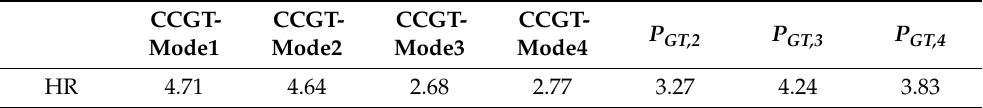
Table 8. Obtained HR for TPPs